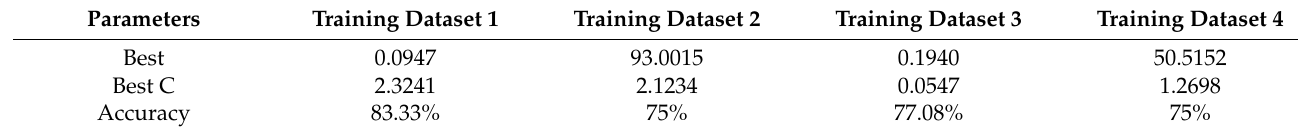
Table 5. The optimal parameters of the SVM model, based on GA.